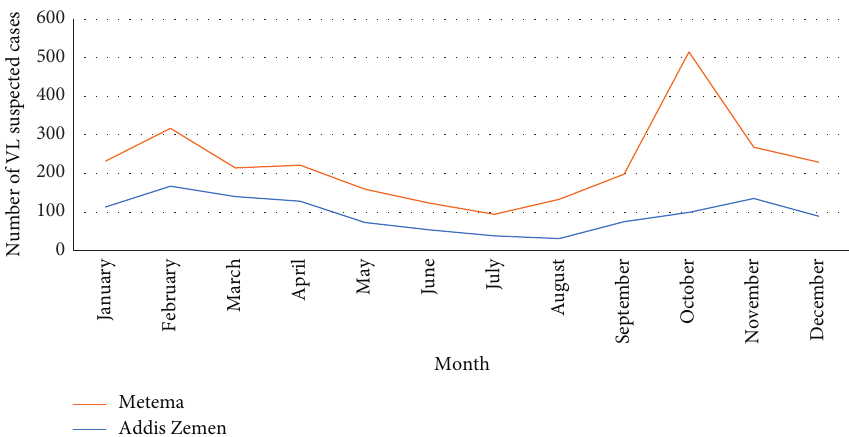
Figure 2: Monthly trends of VL-suspected cases at two health facilities in Ahmara Region northwest Ethiopia from October 2017 to May 2021.